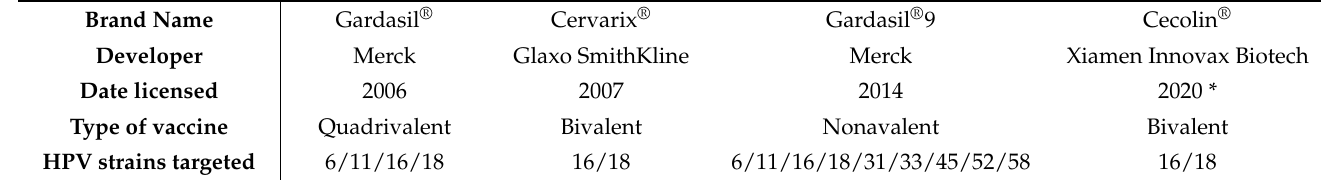
Table 1. Available vaccines to prevent HPV-associated